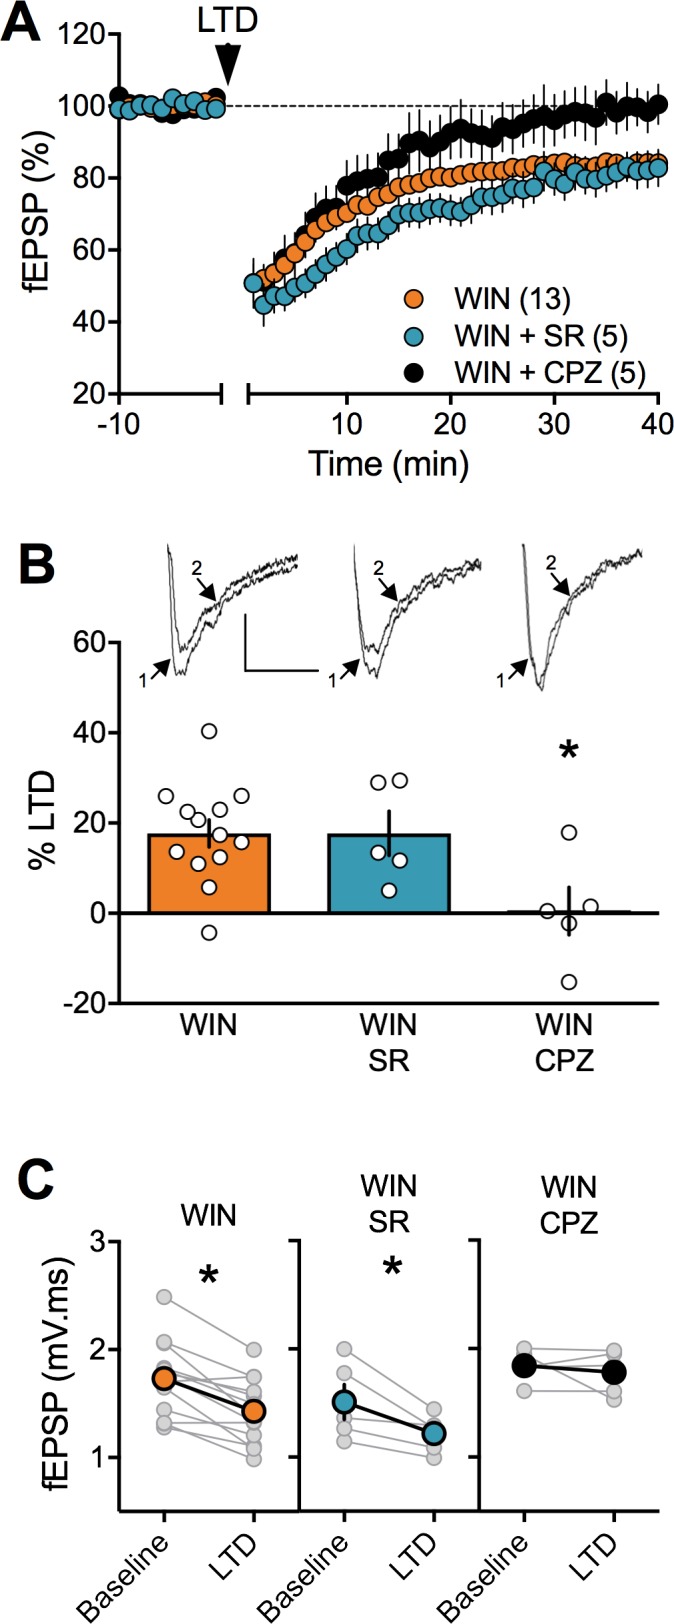
In prenatally exposed female, TRPV1 receptors mediate LTD, not CB1R.(A) Average time course of mean fEPSPs showing that LTD (arrow) is inhibited by the selective TRPV1 antagonist capsazepine (CPZ, black circles, n = 5) but not the CB1R antagonist SR141617A (SR, blue circles, n = 5) in WIN in utero exposed female rats. (B) Summary bar chart of percent LTD calculated from normalized fEPSPs measured 40 min after 10 Hz protocol showing that LTD is blocked by TRPV1 antagonist (black bar) but not by CB1R antagonist (blue bar; p>0.05, one-way ANOVA). Above: example traces, baseline (1) and 40 min poststimulation (2). (C) Plot of individual experiments (grey) showing fEPSP areas before (baseline) and 40 min after stimulation protocol (LTD) in absence (orange, n = 13; p<0.05, paired t-test) and presence of SR141716A (SR, blue, n = 5; p<0.05, paired t-test) or Capsazepine (CPZ, black, n = 5; p>0.05, paired t-test) from WIN-exposed female rats. *p<0.05. n = individual rats. Error bars represent SEM. Scale bar: 10 ms, 0.1 mV.